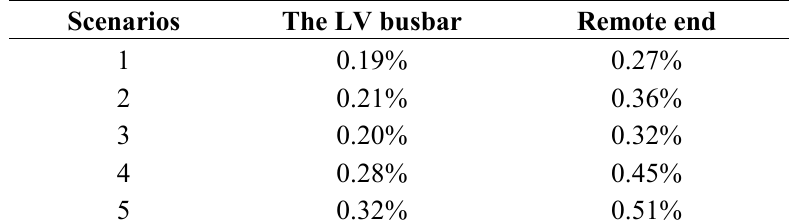
Table 2. Average standard deviations of the 𝑉𝑈𝐹 for the five simulation